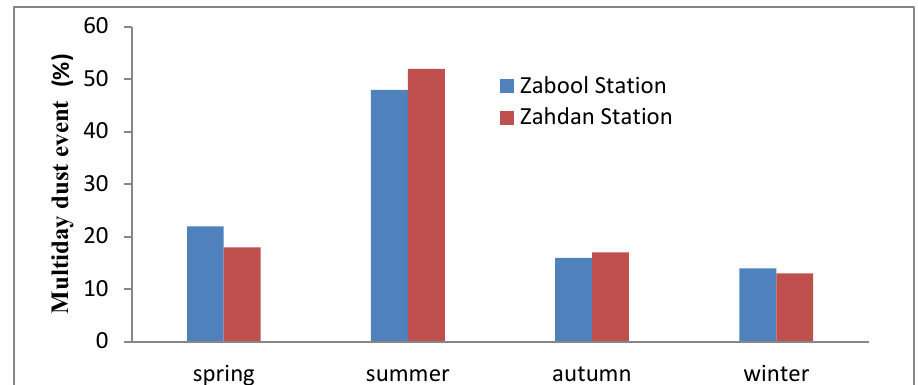
Figure 6. Seasonal diagram of multiday dust events at Zabol and Zahdan station. After Zabol station with 22 days and Zahdan with 21 days, the next longest DDD was recorded at Anar, Nain, and Saveh stations with 8 days, as shown in Figure 7. There is a big difference between the DDD values of Zahdan and Zabol stations and other stations in the study area. Although stations in the central deserts of Iran such as Khor, Biabank, Yazd, and Semnan, also have favorable climatic and edaphic conditions for wind erosion, the Zahdan and Zabol stations are the most affected by the 120-day winds of Sistan, known as the monsoon winds, that blow continuously over prolonged periods.